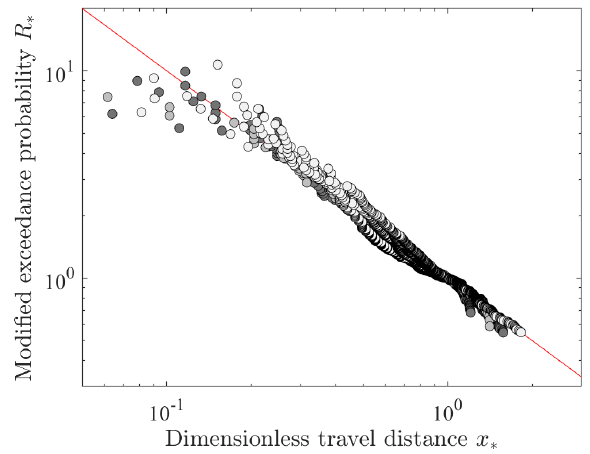
Figure 8. Plot of modified exceedance probability R ∗ versus non-dimensional travel distance x ∗ for angular (dark gray), small (medium gray), and rounded (light gray) particles, and slopes S = 0 . 00 to S = 0 . 28. The collapse of these values to a straight line with a slope − 1 in log–log space indicates consistency with a generalized Pareto